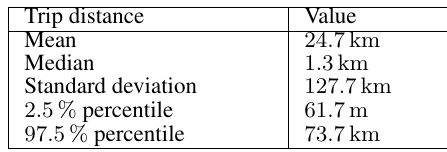
Table 5. Statistical details of all trip